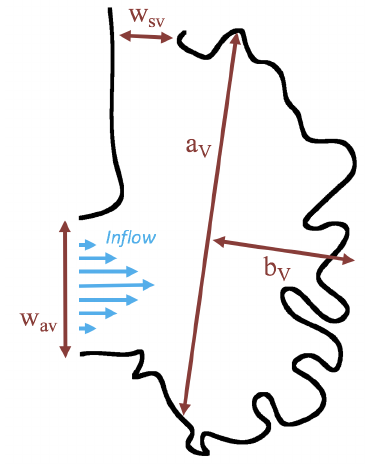
Figure 4. Schematic diagram showing the parameters for the biologically realistic simulations. Note that a V is the characteristic length for selecting the correct Re